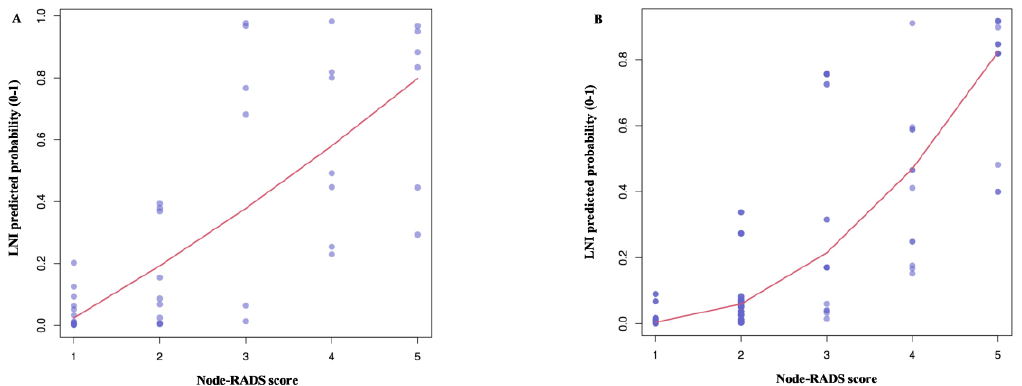
Figure 3. Local polynomial smoother function (LOESS) depicted the predicted probability of lymph- node invasion (LNI) according to the Node-RADS score at the patient level ( A ) and at the lymph node level ( B ). Predicted probability was derived from a multivariable logistic regression model accounting for important cofounders (age, cT stage, and concomitant CIS at last TURBT).